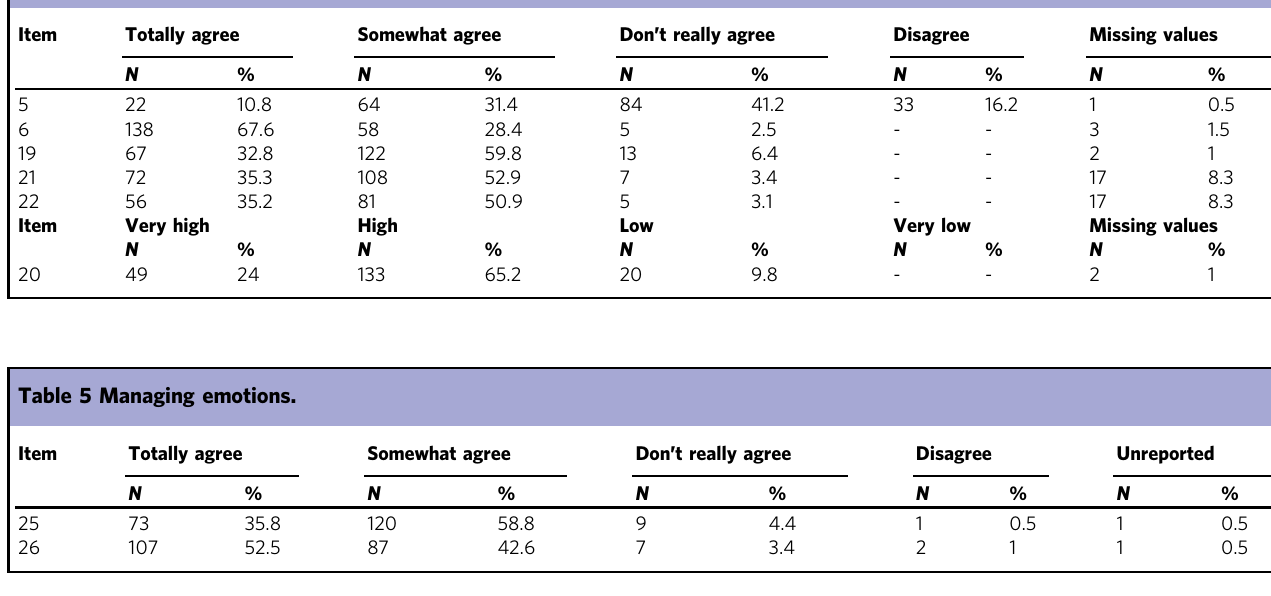
Table 4 Addressing con fl icts.